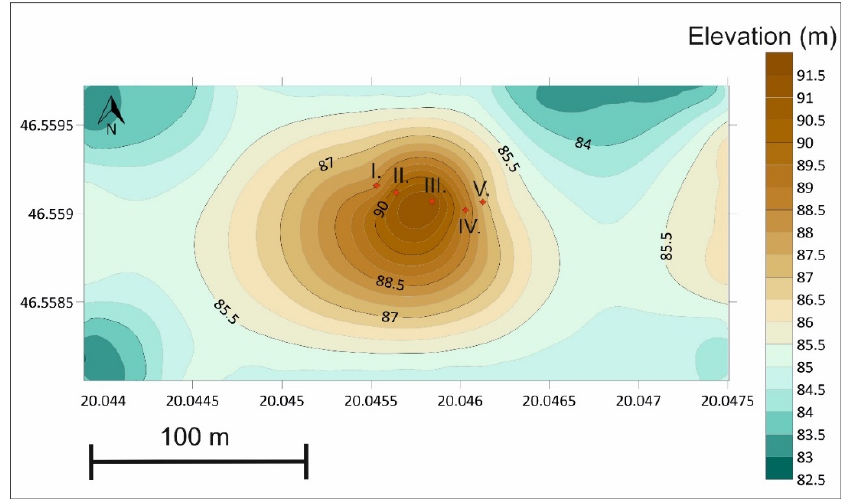
Figure 4. The geomorphology of the mound and its surroundings. Red squares with numbers are the mapping drillings and the central drilling (III.) from where the samples for the measurements were yielded from.